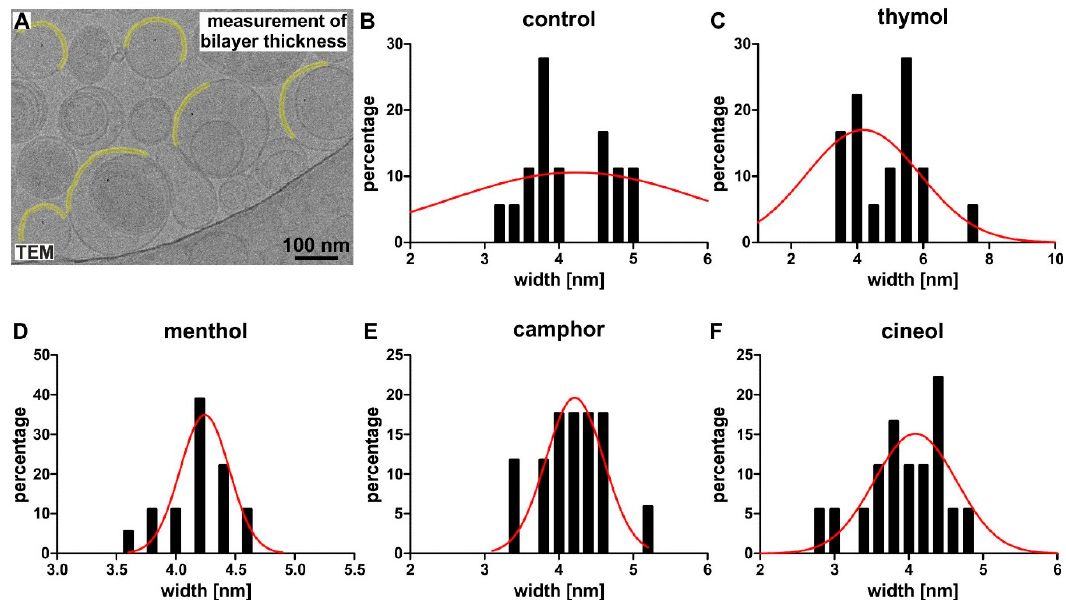
Figure 6. Encapsulation of terpenoids does not affect the bilayer thickness of invasomes. ( A ) Example of a small representative section of an original cryo-electron micrograph used for measurement of the bilayer thickness. ( B – F ) A similar liposomal bilayer thickness was observable for control invasomes (4 ± 0.5 nm), thymol-invasomes (5 ± 1 nm) menthol-invasomes (4 ± 0.3 nm), camphor-invasomes (4 ± 0.5 nm) or cineol-invasomes (4 ± 0.5 nm). Frequency plots of the bilayer thickness distribution of invasomes. A fit with the Gaussian function is displayed as a red line.